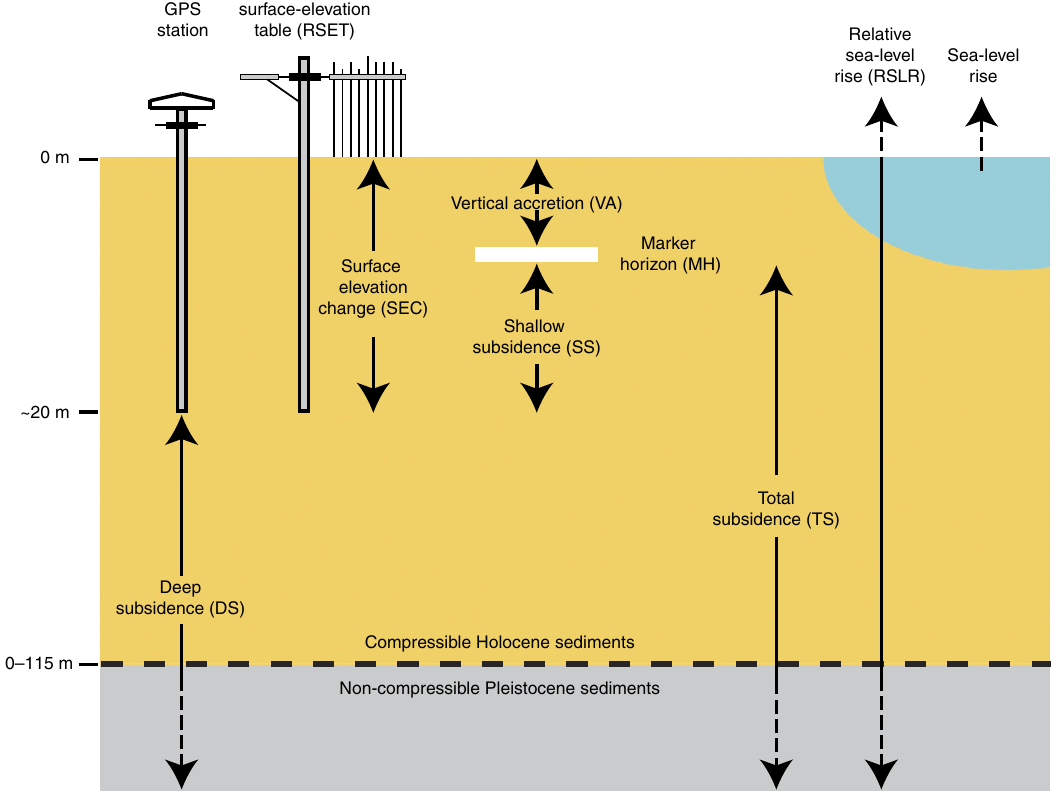
Figure 1 | Relationship between study variables. Representation of SEC, VA, SS (VA (cid:2) SEC), DS, TS (SS þ DS), sea-level rise and RSLR (TS þ sea-level rise) as used in this study. When the VA rate exceeds the rate of RSLR there is an accretion surplus; when the VA rate is less than the rate of RSLR there is an accretion deficit. Figure is not to scale. Modified from ref.